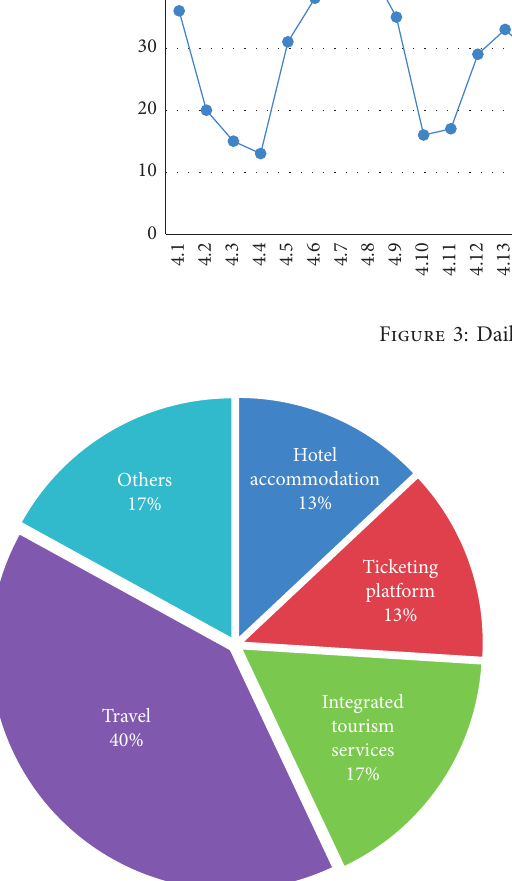
Figure 4: Function comparison relationship of tourism platform.